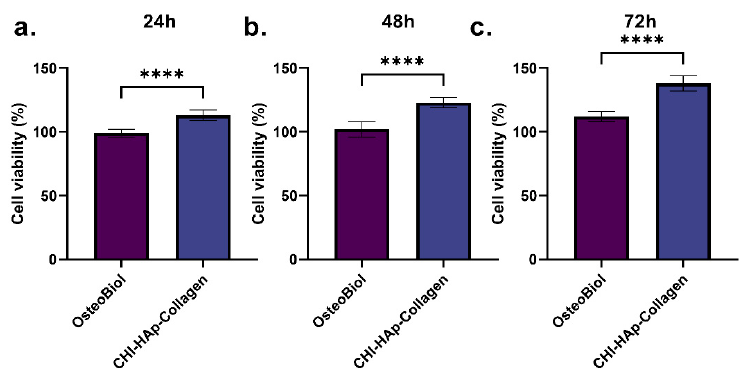
Figure 3. DPSC viability after ( a ) 24, ( b ) 48, and ( c ) 72 h of treatment. OsteoBiol—collagen mem- brane; CHI–HAp–collagen—collagen membrane with addition of nano-hydroxyapatite and chitosan; **** p < 0.0001.